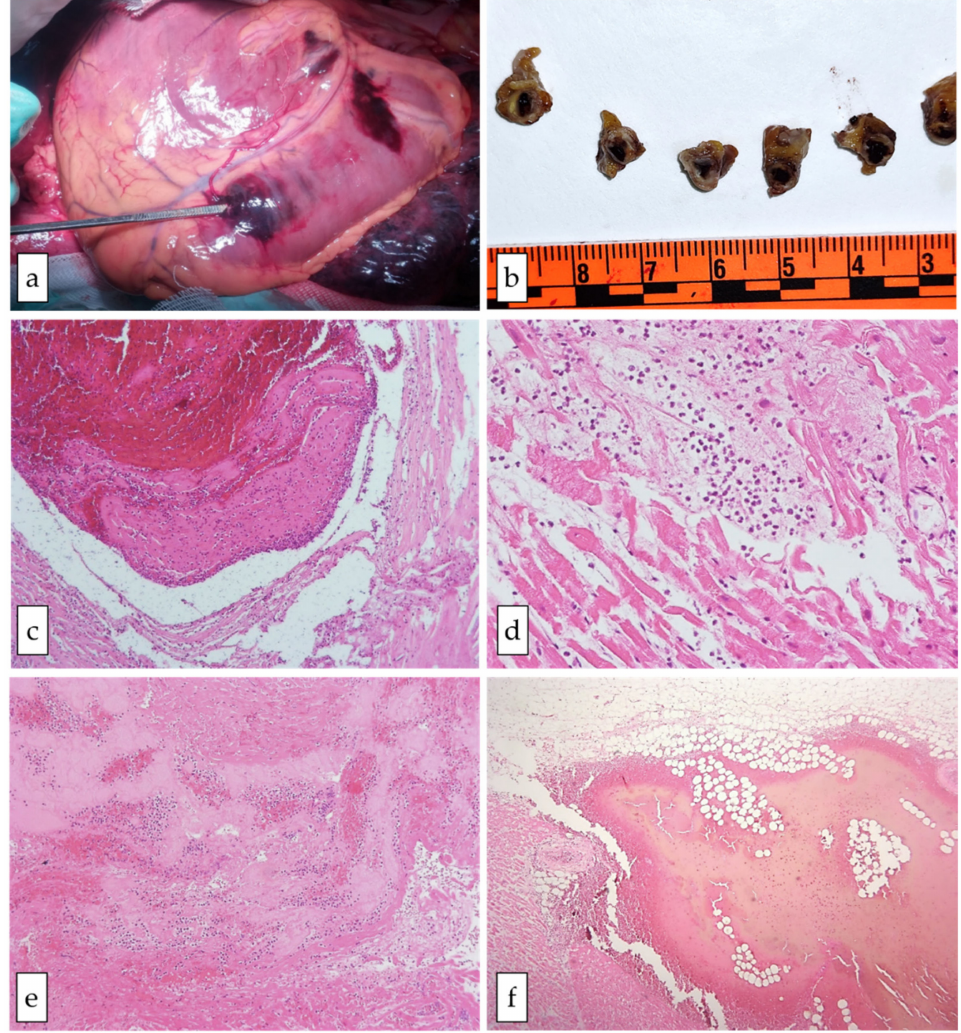
Figure 1. Gross and microscopic cardiac features in case #1. Panel ( a ) shows the transmural myocardial rupture. Panel ( b ) shows the transversal section of the coronary artery with evidence